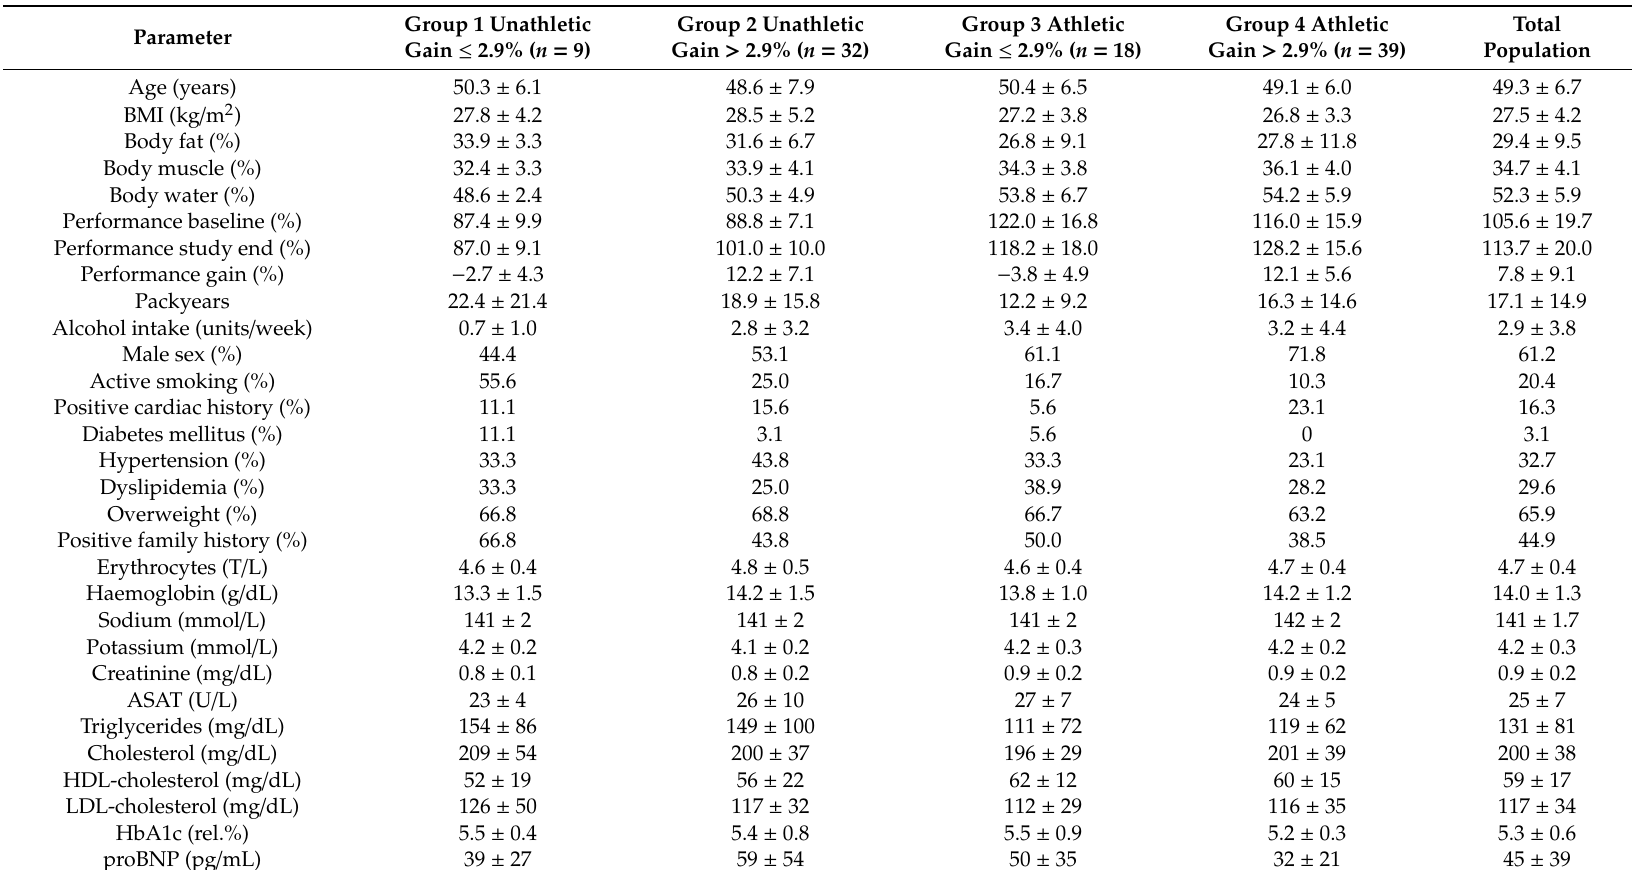
Table 1. Anthropometric and body composition data, as well as the cardiovascular risk profile, an extraction of the lab data at baseline and performance data at baseline and after eight months of